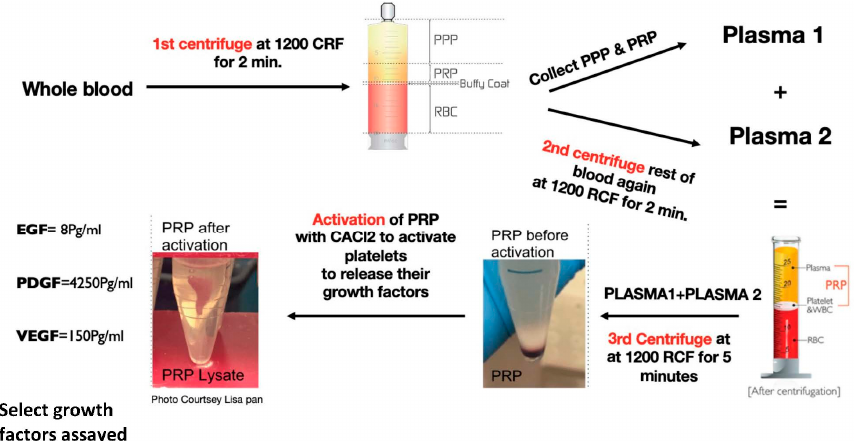
Figure 1. Diagram showing the processing method performed in our lab to obtain PRP Lysate. ELISA quantified growth factors in the PRP lysate used in the migration assay are shown on the left.